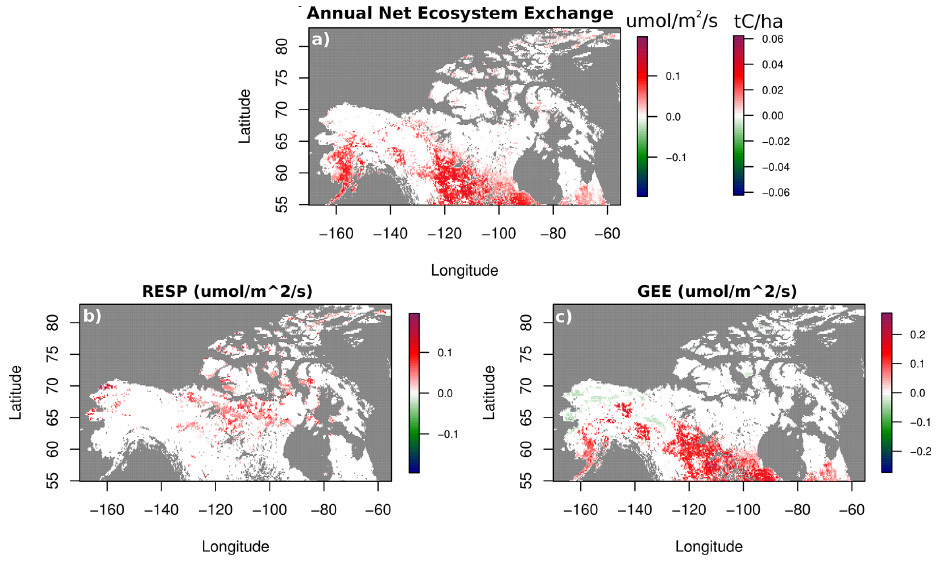
Figure 7. Sen’s slope values, indicating the median change (2001–2012) in PolarVPRM estimates of mean annual NEE (a) , respiration (b) and GEE (c) . In (a) , changes over time in NEE are indicated in bothµmol CO 2 m − 2 s − 1 and tCha − 1 using the same color scheme. All Sen’s slope values shown correspond to p values < 0 . 05. Pixels with > 50% fractional water content are indicated in grey. Please note that the negative sign convention in GEE has been maintained, meaning that a positive trend in GEE corresponds to diminished uptake of carbon through